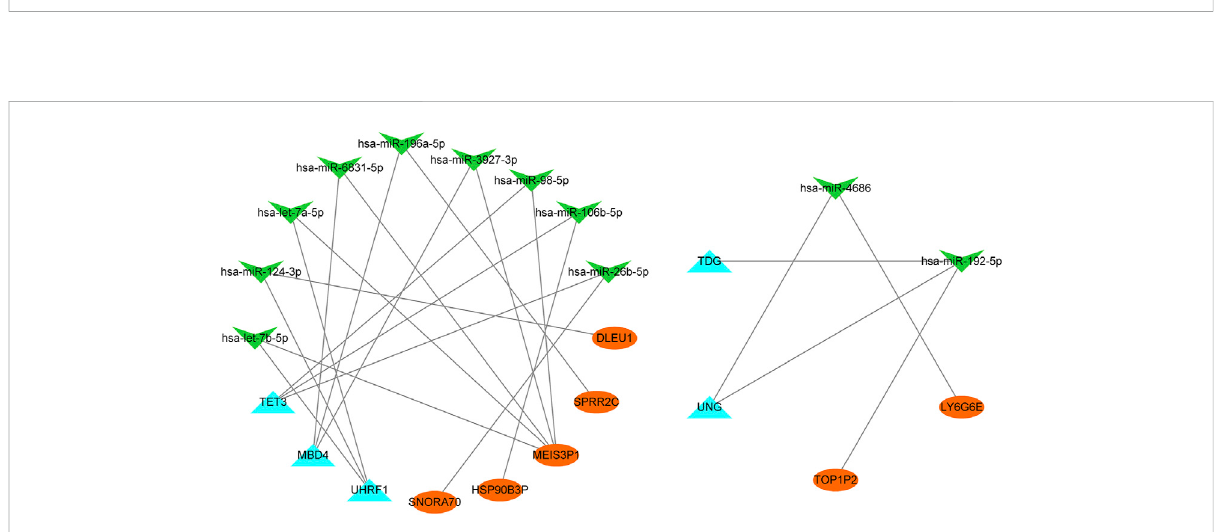
FIGURE 10 CeRNA network. MiRNAs (green arrow), m5C-related genes (blue triangle), and lncRNAs (orange oval) are